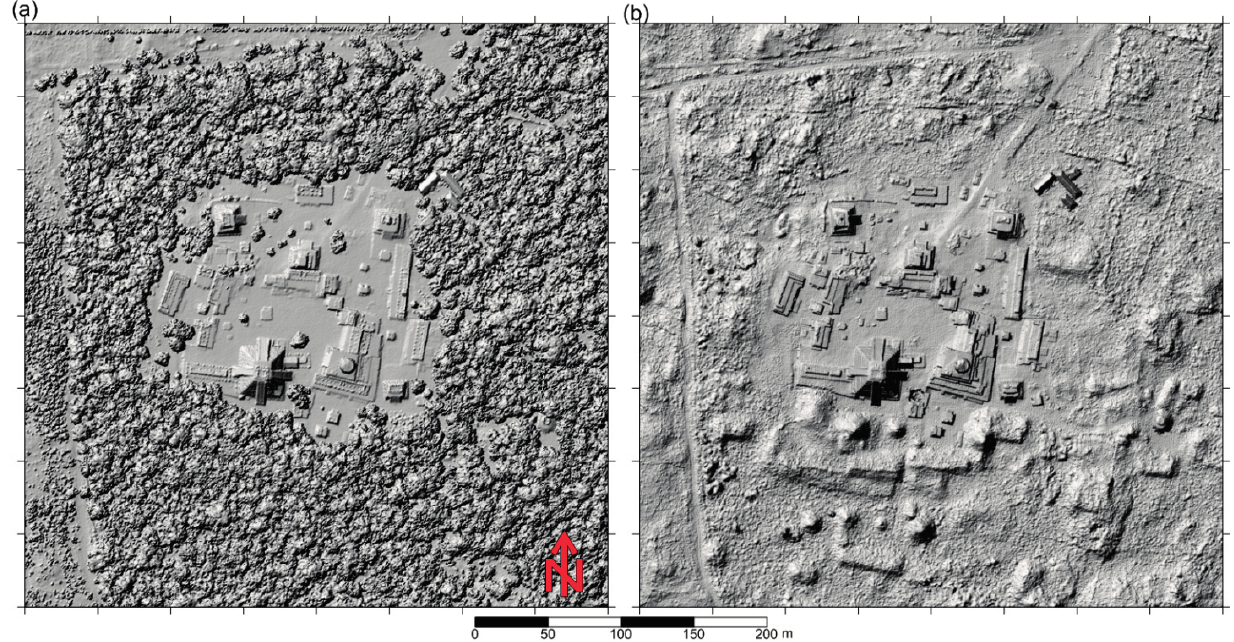
Figure 6. Shaded relief images from Mayapan, Mexico, generated from ( a ) A first return digital surface model (DSM); ( b ) A vegetation filtered digital elevation model